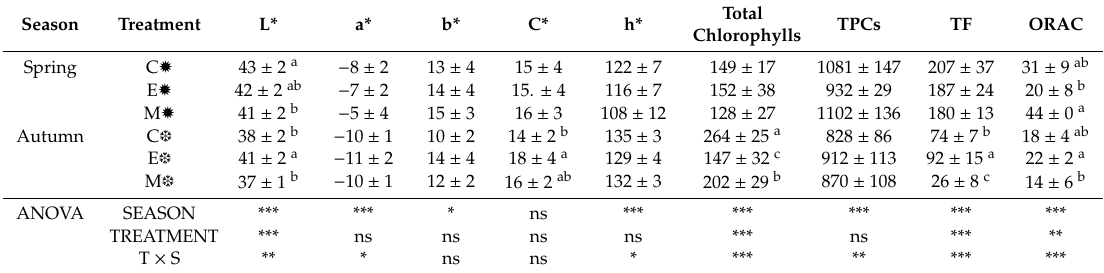
Table 1. Color parameters, chlorophyll content (mg / kg of f.w.), total phenolic compounds